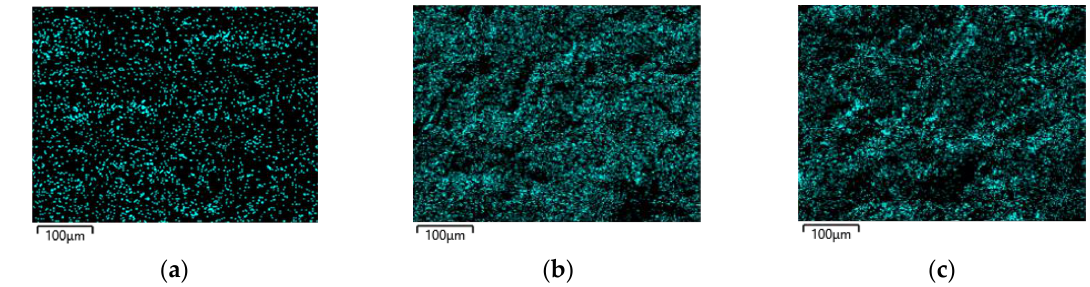
Figure 5. SEM images and elemental distribution on the surface of 304L stainless steel after LP: ( a ) 304L, ( b ) 304L-L-NC, and ( c ) 304L-L-WC.